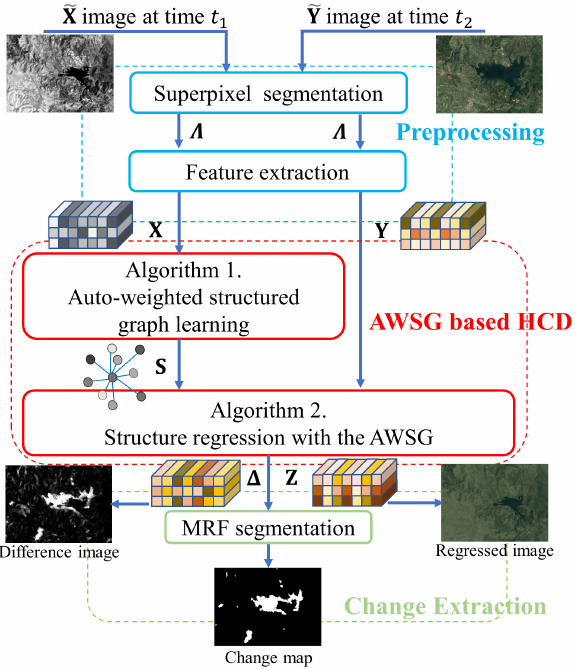
Figure 1. Framework of the proposed AWSG-based HCD